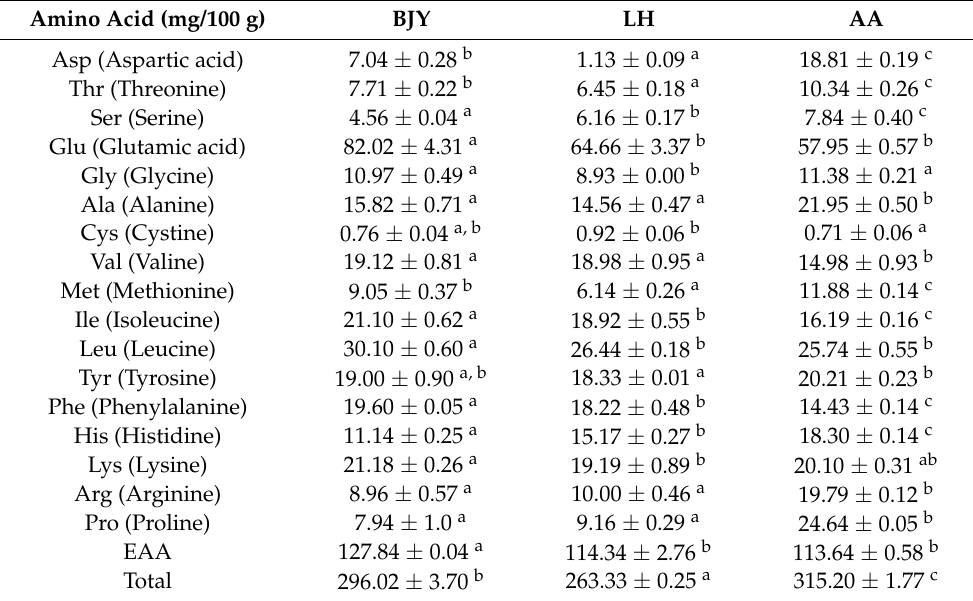
Table 3. Free amino acid contents of different types of chicken breast (mg/100